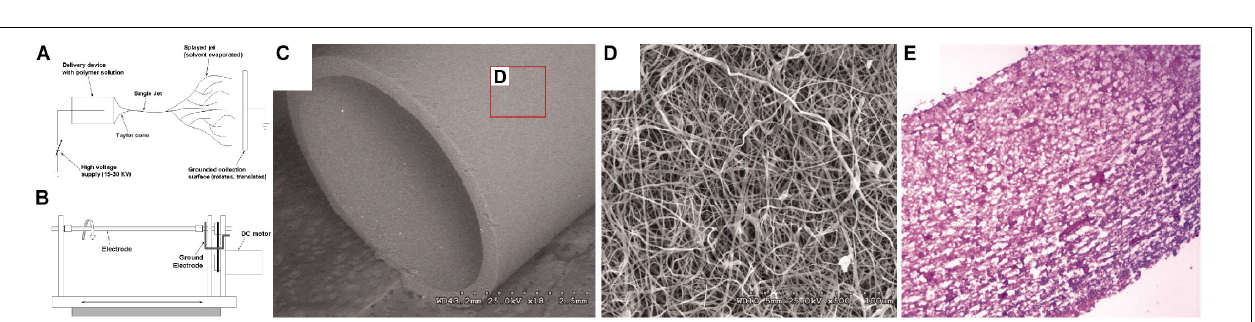
FIGURE 3 | Example of tubular scaffold for intestinal tissue engineering constructed through the casting process (Chen et al., 2015). (A) Schematic showing scaffold production. Silk is lyophilized in a mold to create a porous scaffold with a central lumen. Cells are seeded into the scaffold and into the interior of the lumen. (B) Image showing scaffold lumen. Scale bar is 4 mm. (C) Immunostain for ZO-1 and cell nuclei (DAPI). Scale bar is 100 µ m. (D) Scanning electron microscopic (SEM) image of epithelial lining. Scale bar is 1 µ m. (E) Alkaline phosphatase (ALP) staining for ALP enzymatic activity on interior lining of lumen. Scale bar is 200 µ m. (F) Confocal z-stack of cells in scaffold immunostained for SM22a, a marker for myofibroblasts. Scale bar is 50 µ m. Images were reordered from multiple panels, and lettering has been relabeled for consistency as part of this review article (Chen et al., 2015). These images are reprinted under Creative Commons Attribution 4.0 International License, available at http://creativecommons.org/licenses/by/4.0/.